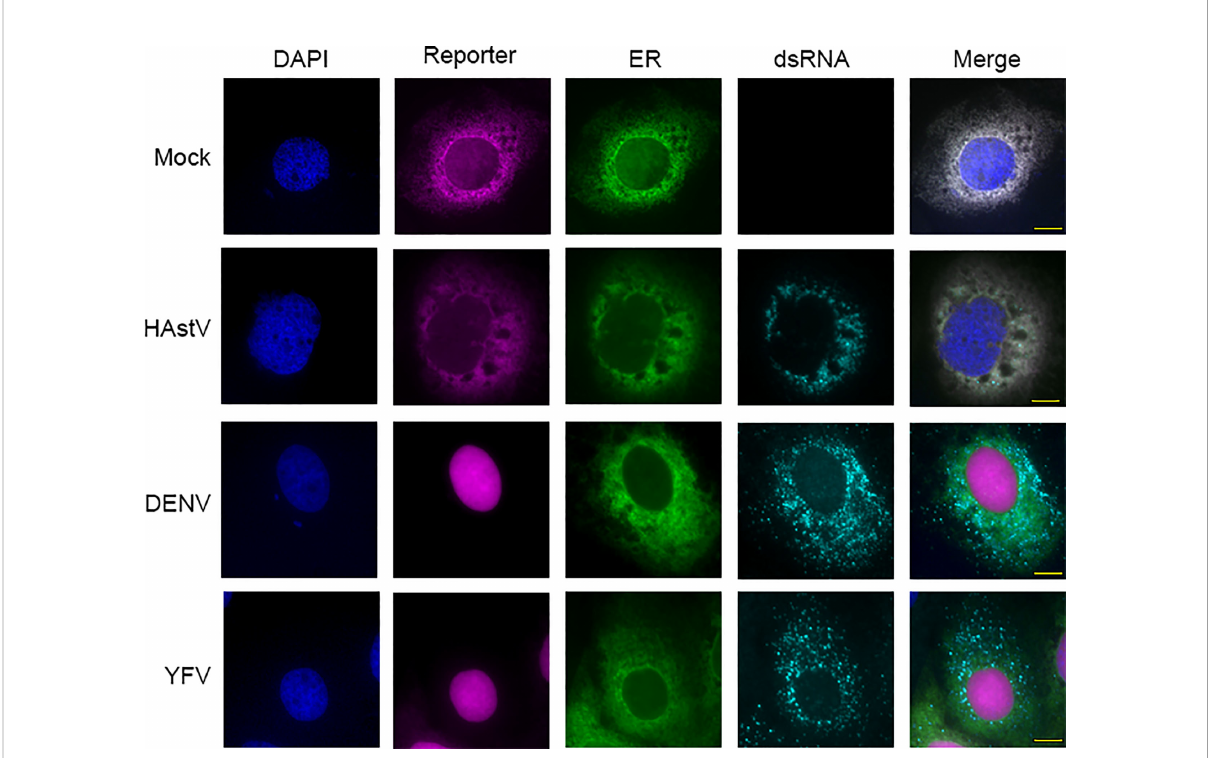
FIGURE 4 FlavER cleavage is speci fi c to fl avivirus infection. Immuno fl uorescence microscopy of Huh7 cells expressing FlavER and infected with the indicated virus (MOI=3). Reporter is shown in magenta, ER marker is shown in green, dsRNA staining is shown in red, and nuclei are stained with DAPI (blue). Cells were fi xed and stained 24 hours post